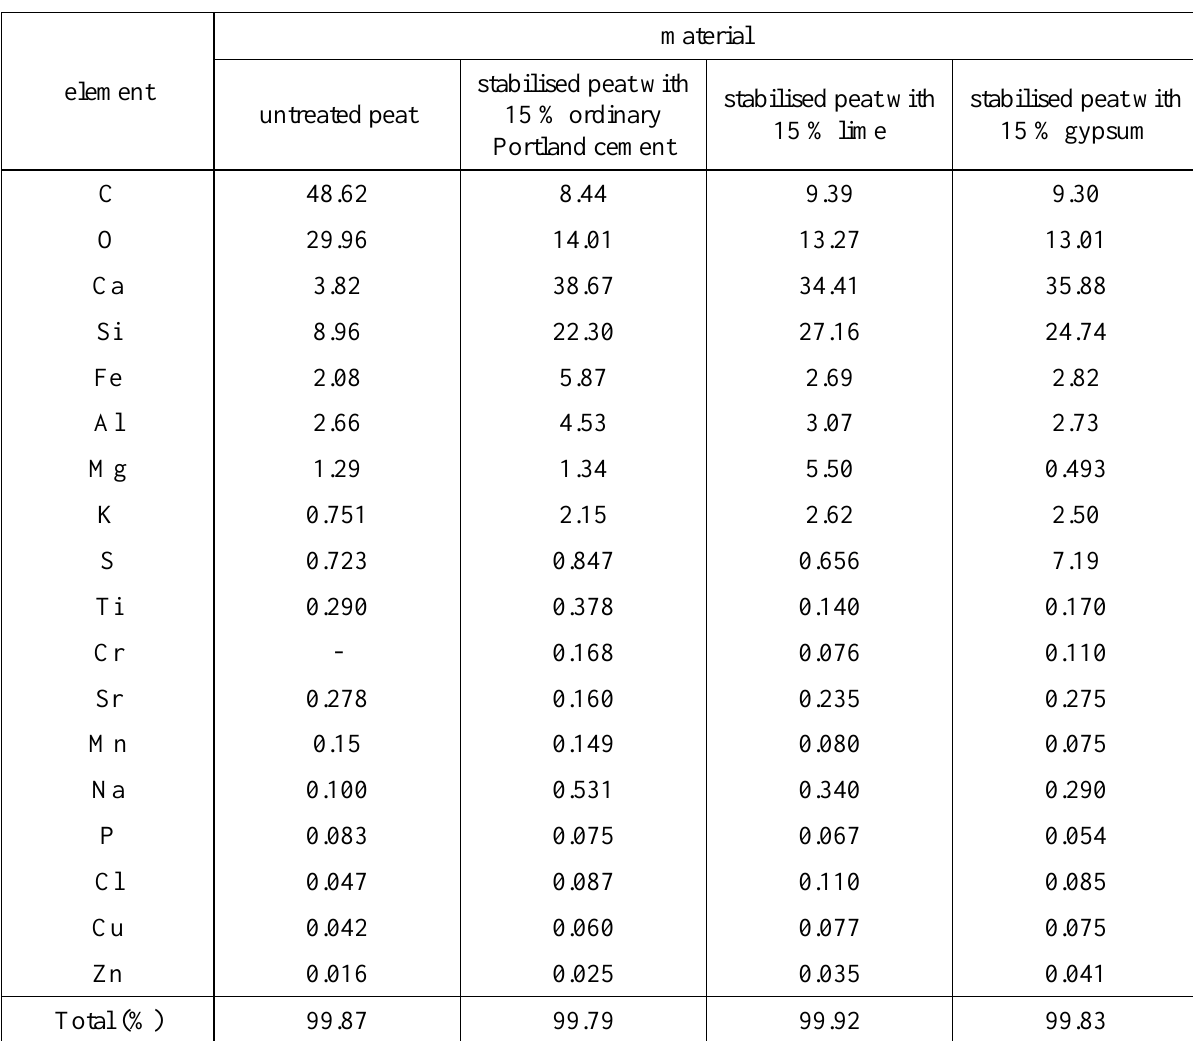
Table 7. Element composition (% by weight) of peat specimens in untreated condition and after stabilisation with sand in combination with one of the tested pozzolanic additives (dosage 15 %) after curing for 28 days, determined by X-ray fluorescence (XRF). The data for untreated peat are taken from Rahgozar & Saberian (2015).